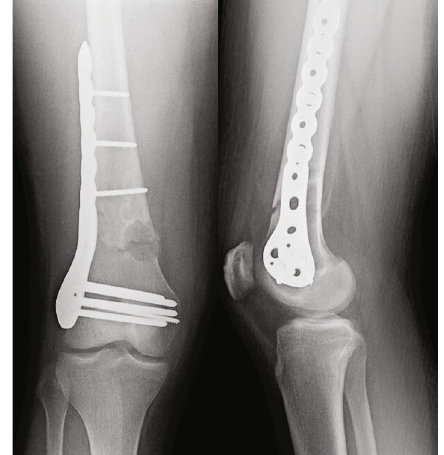
Figure 2: AP and lateral plain radiographs taken in clinic approximately 1 month postoperatively, demonstrating healing fracture.